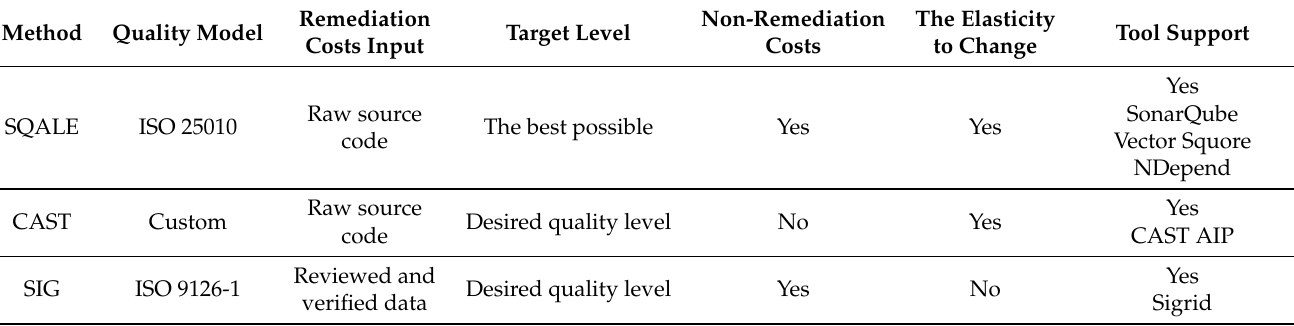
Table 1. Leading methods and tools for measuring technical